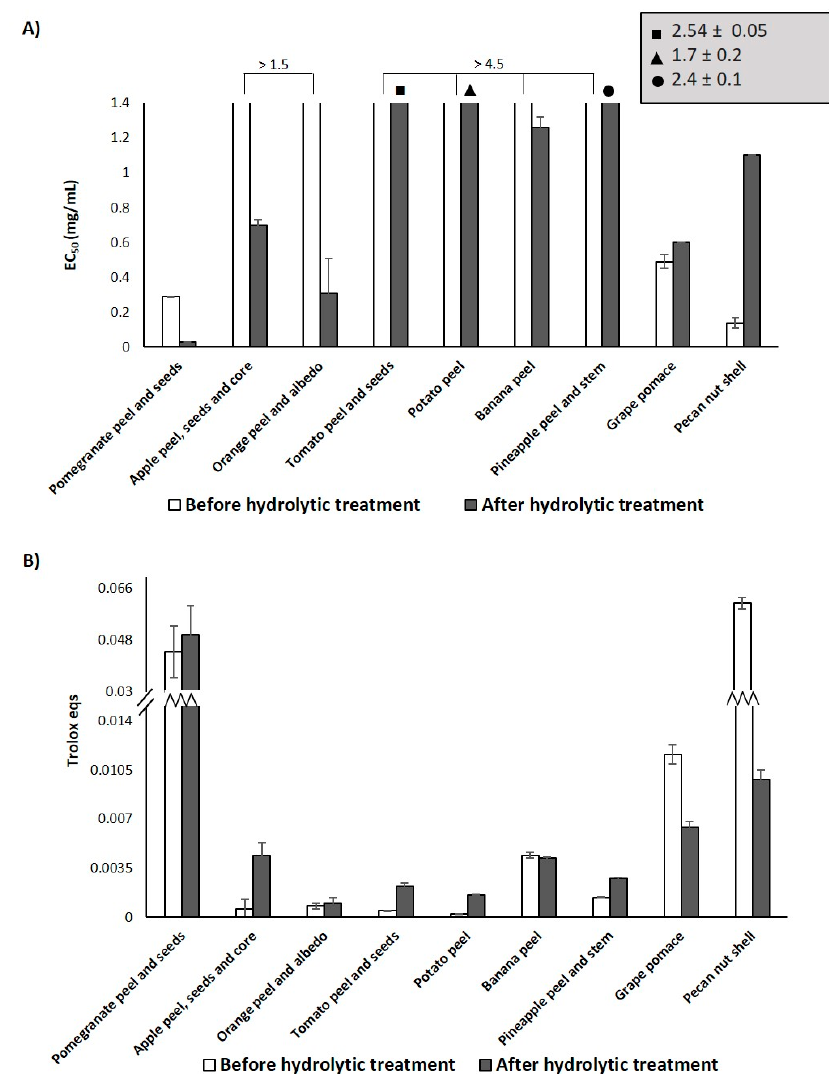
Figure 1. Antioxidant properties of agri-food byproducts before and after hydrolytic treatment. ( A ) DPPH assay; ( B ) FRAP assay. Reported are the mean ± SD values of at least three experiments.